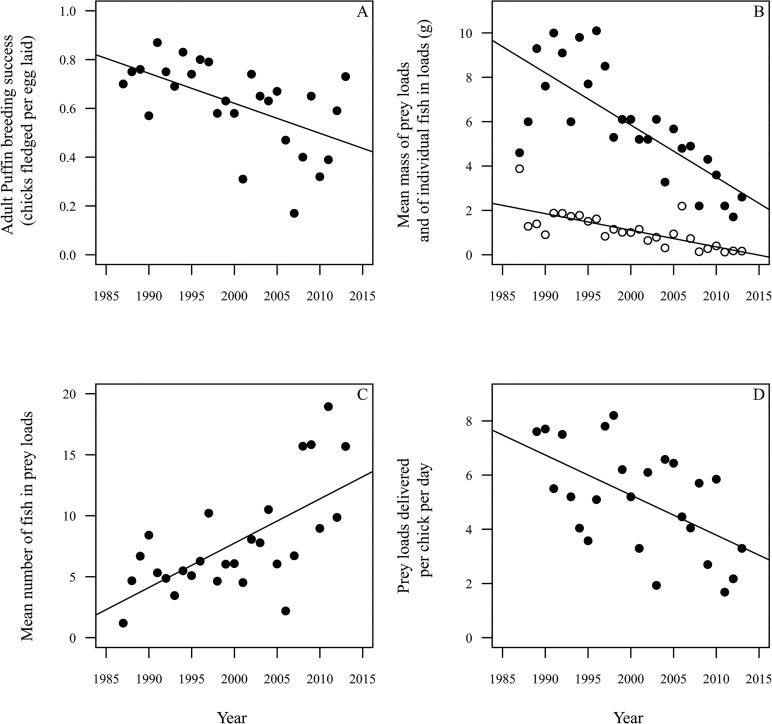
Atlantic Puffin breeding success and chick diet characteristics.A. Adult Atlantic Puffin breeding success, 1987 to 2013; B. mean total mass of prey loads landed by adult Atlantic Puffins for chicks, filled circles, and mean mass of individual fish in loads, open circles, 1987 to 2013; C. mean number of fish in loads, 1987 to 2013; D. number of fish loads delivered per chick per day in mid-July, 1989 to 2013. Lines represent fitted linear regressions.